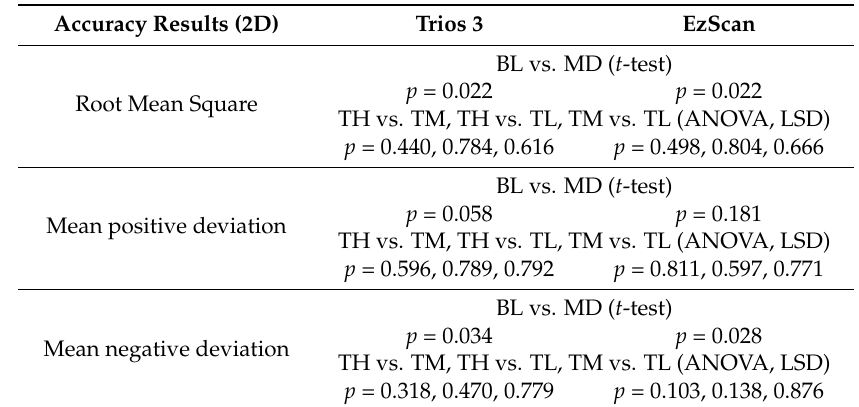
Table 2. Results of 2-dimensional analysis for accuracy at BL vs. MD and TH vs. TM vs. TL for each intraoral scanner (Trios 3 ® , EzScan ® ) expressed with RMS, mean positive deviation, and mean negative deviation